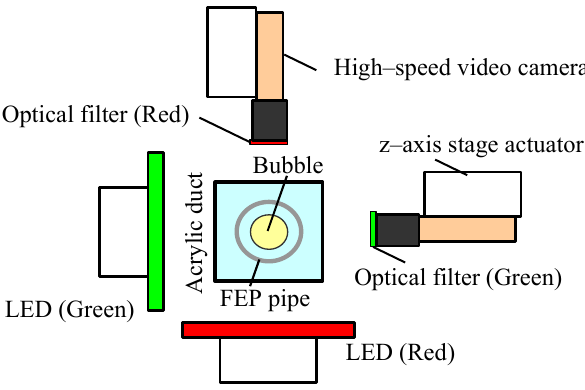
Fig. 2 Cross section of test